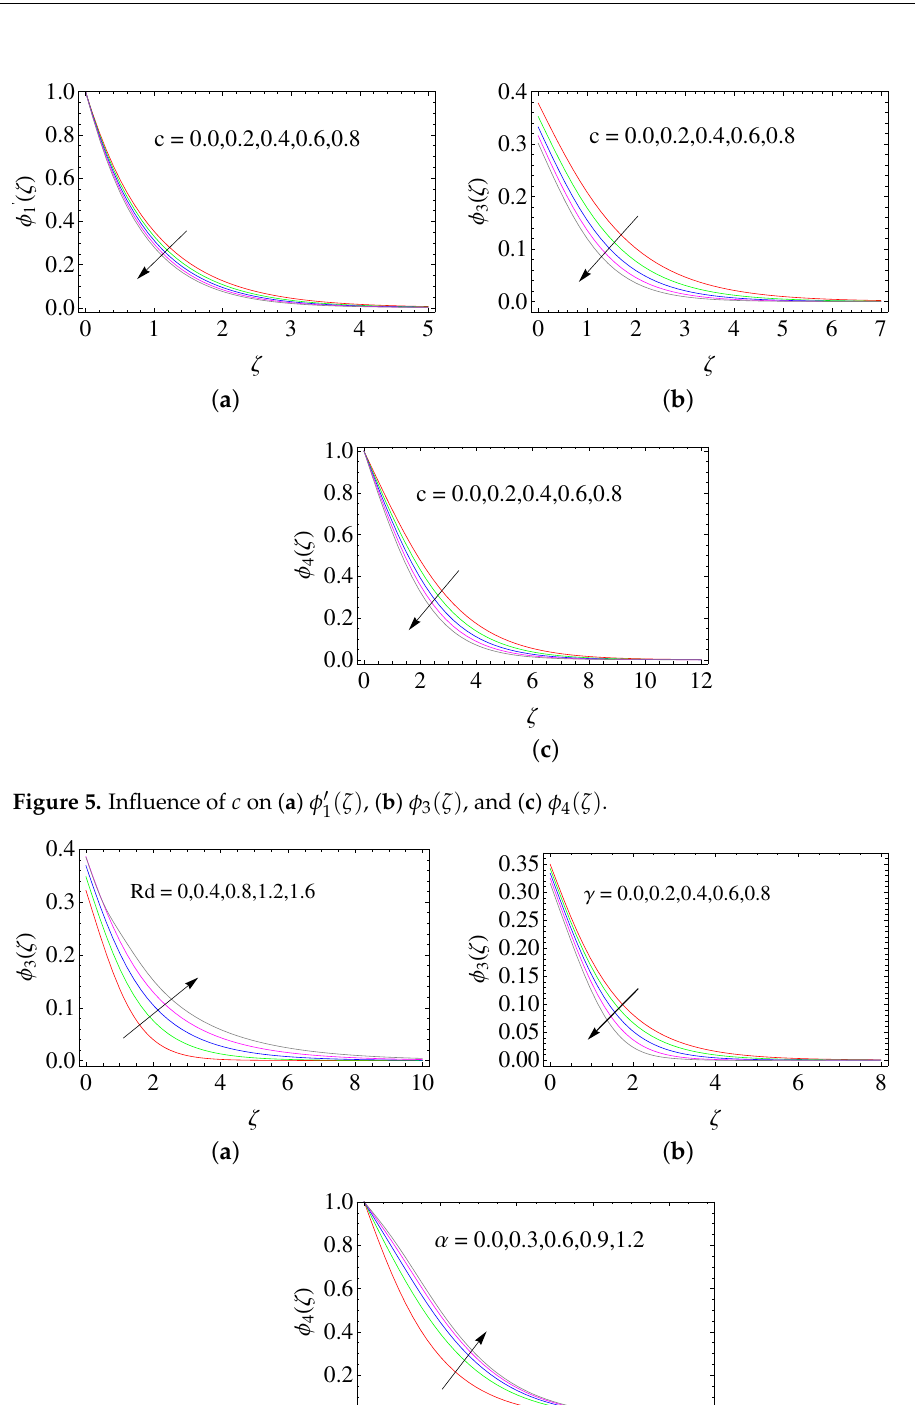
Figure 6. Influence of ( a ) Rd and ( b ) γ on φ 3 ( ζ ) , and ( c ) α on φ 4 ( ζ ) . The skin-friction coefficient along the x- and y-directions rises upon boosting the ratio of the relaxation to retardation time ( λ 1 ) (see Figure 7). From Figure 8, it is clear that the local Nusselt number diminishes by magnifying both Rd . Also, the local Nusselt number enhances by raising α . In Figure 9, the local Nusselt number diminishes on raising λ 1 and Nb . From Figure 10, it is observed that local Sherwood number enhances with a rise in Rd and Nb